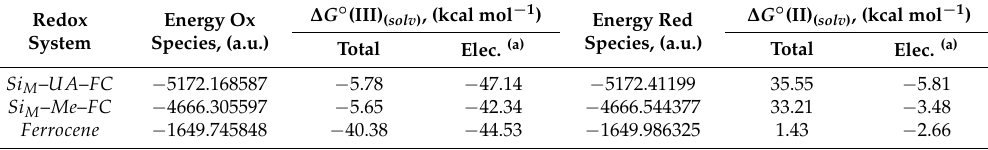
Table 1. PBE0/6-31G* theoretical values used to calculate the standard potential. Redox Energy Ox Species, System (a.u.)